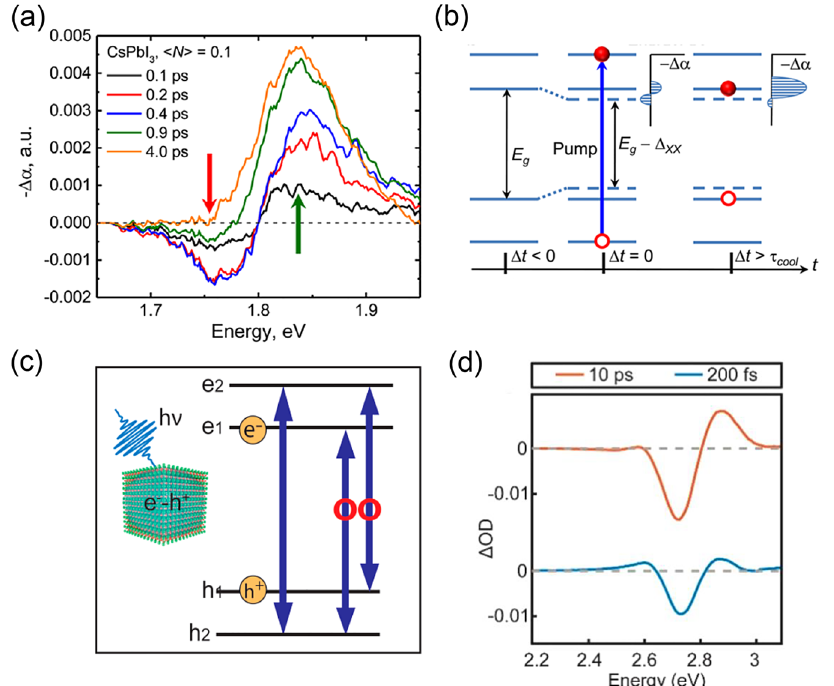
Figure 6: (a) TA spectra of CsPbI 3 nanocrystals at different time delays. The red and green arrows denote the PIB and the low-energy ESA features. (b) Sche- matic of TA evolution at early delay time. The transition energies seen by the probe pulse are modi fi ed by the exciton-exciton interaction (dashed lines). In the case of exciton-exciton attraction (shown in this sample),theenergyforthetransitionfrom the exciton to biexciton states is smaller than the single-exciton transition energy.